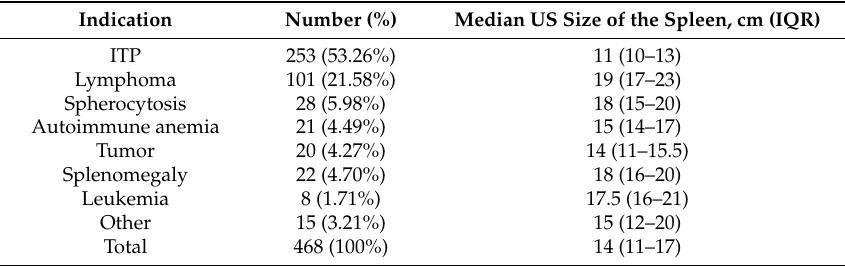
Table 1. Indications for LS.